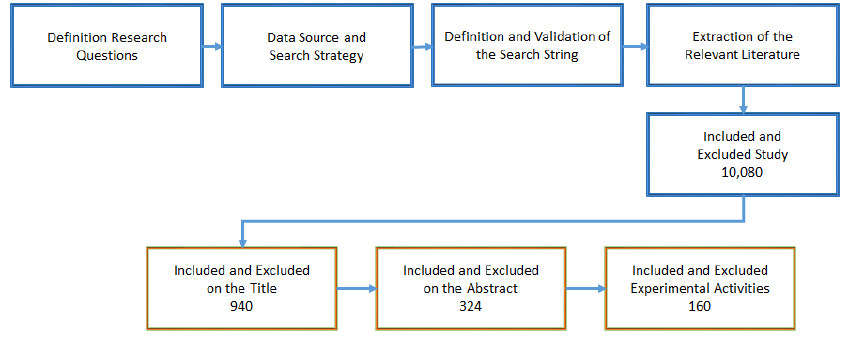
Figure 1. Reseach Figure 1. Reseach method.